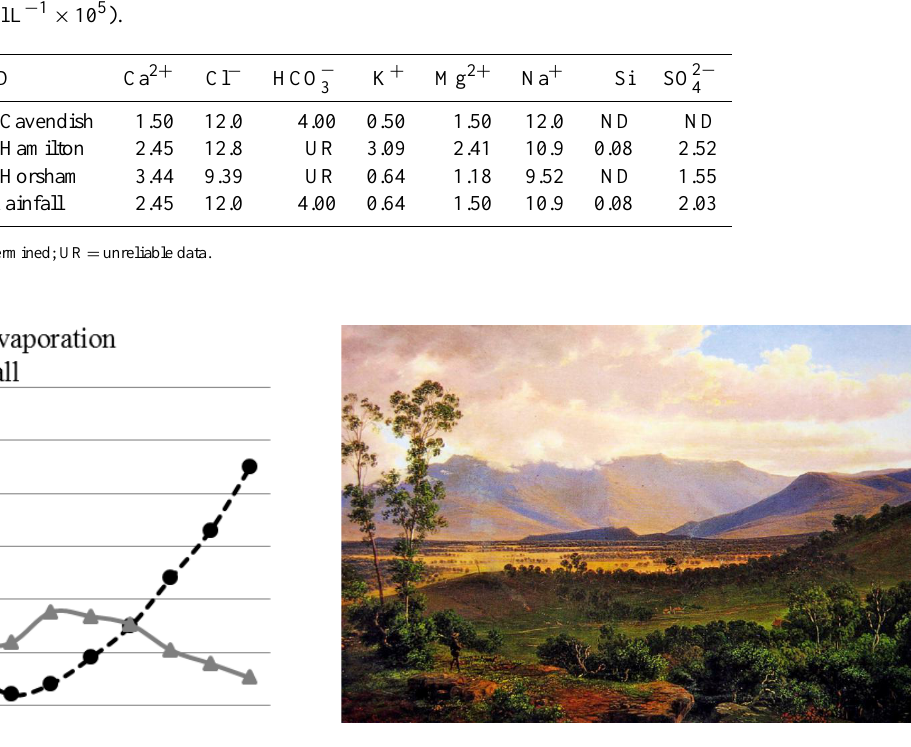
Figure 3. Painting of Victoria Valley prior to land clearance (Eugene vo Guérard, 1866; courtesy of Sotheby’s Australia).